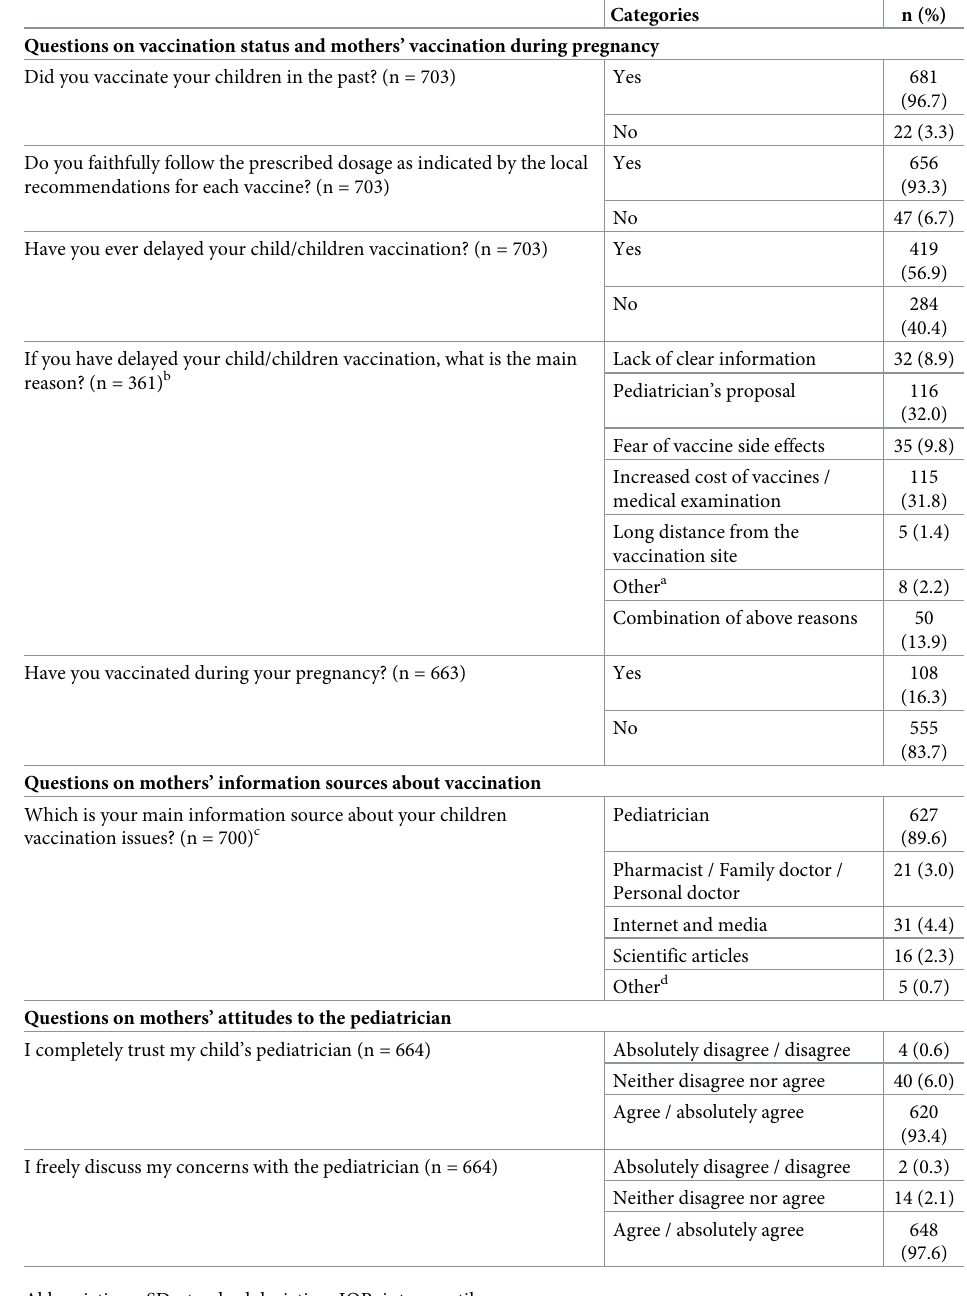
Table 2. Mothers’ responses to questions on vaccination status of their children and their own vaccination status during pregnancy, their attitudes to the pediatrician and their information sources about vaccination. Categories n (%) Questions on vaccination status and mothers’ vaccination during